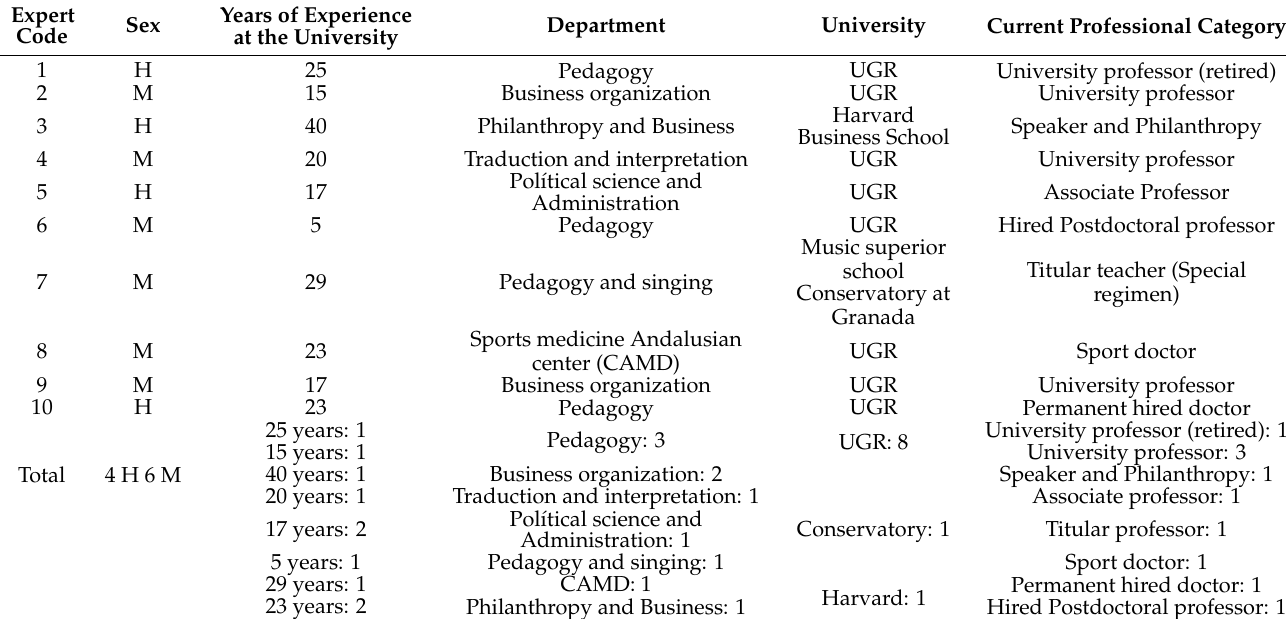
Table 2. Expert’s identification